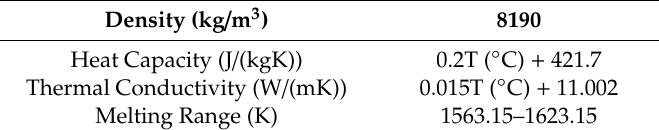
Table 2. The thermal properties of Inconel 718.